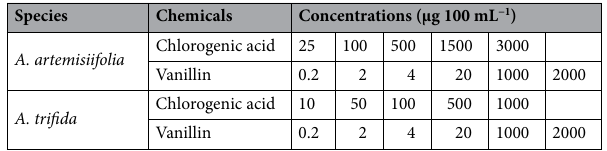
Table 4. Specific concentration Settings of chlorogenic acid and vanillin verification